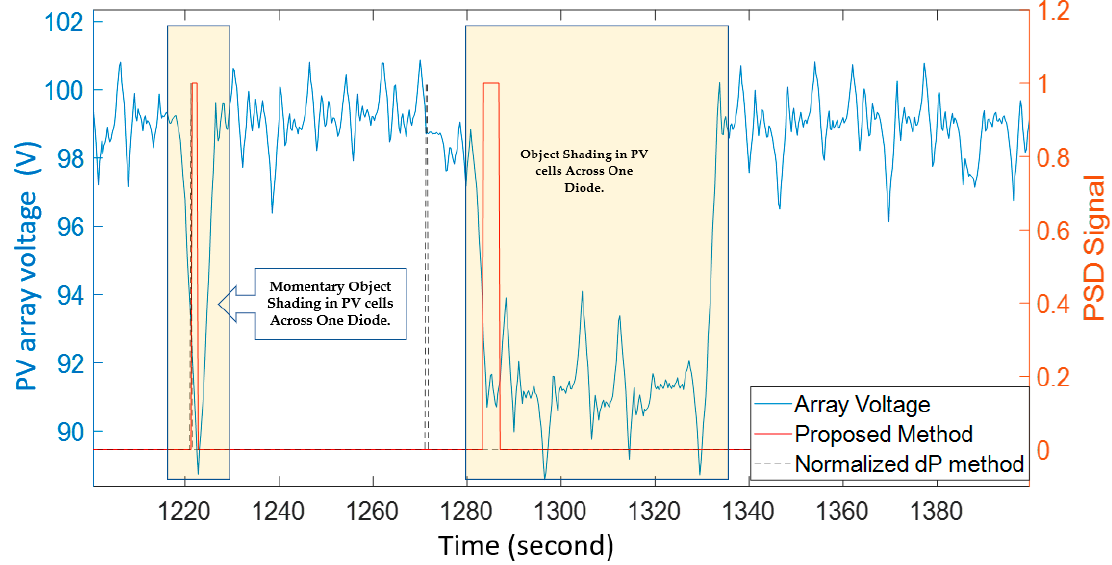
Figure 6. Series–parallel PV array voltage waveforms and PSD signals during the object shading simulation.